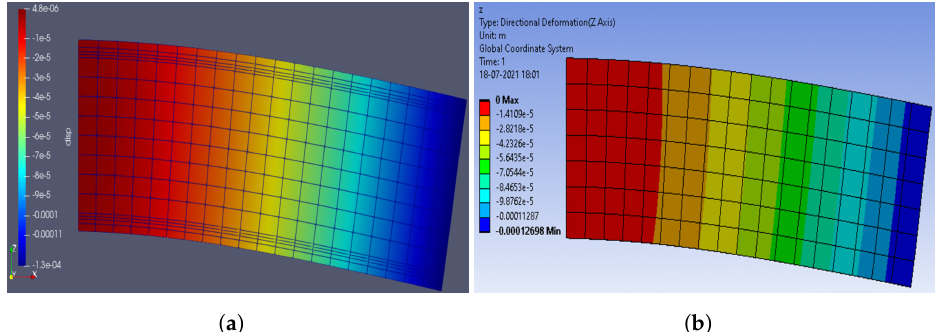
Figure 6. One side fixed beam, submitted to self weigth and a force at the non-fixed side (1000 N). ( a ) Paraview (Python), ( b ) ANSYS.